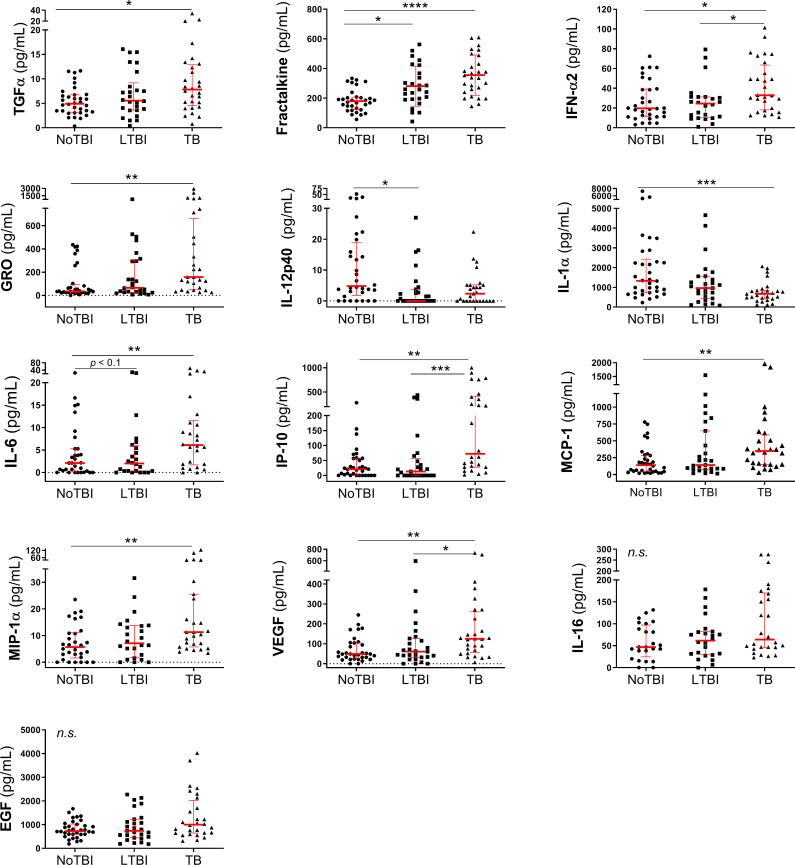
Concentration of protein markers detected in saliva samples.The horizontal bars represent the median and the interquartile range. Differences between study groups were calculated using a Kruskal-Wallis test followed by a Dunn´s test corrected for multiple comparisons. Significant differences between groups are expressed as: * p < 0.05; ** p < 0.01; *** p < 0.001; ****p < 0.0001 and ns: no significant differences.